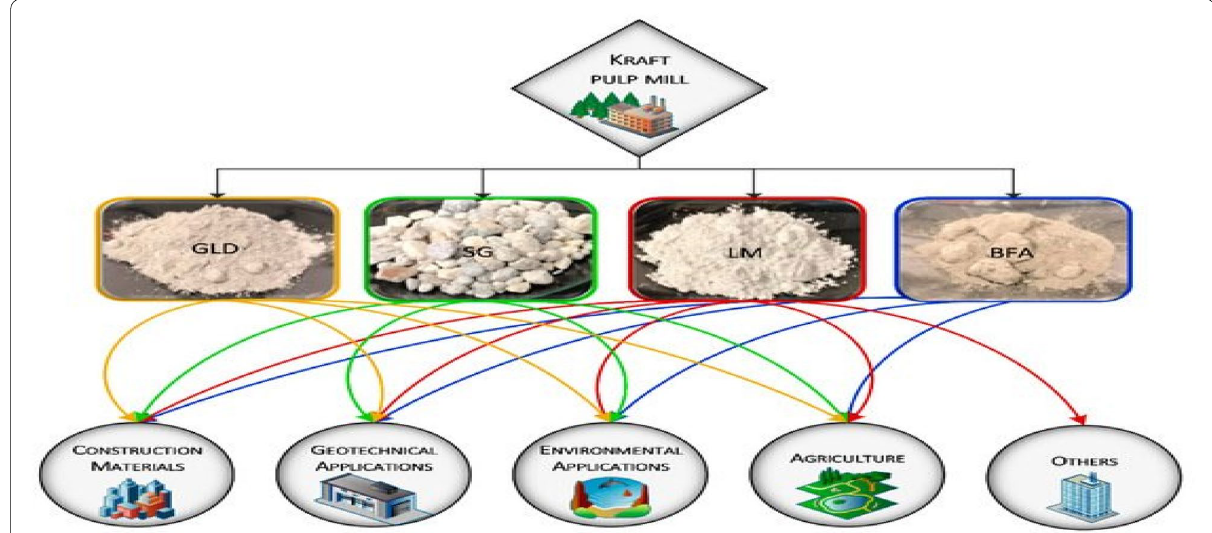
Fig. 7 Current utilization of pulp and paper mill inorganic wastes ( GLD green liquor dregs, SG slacker grits, LM lime mud, BFA boiler fly